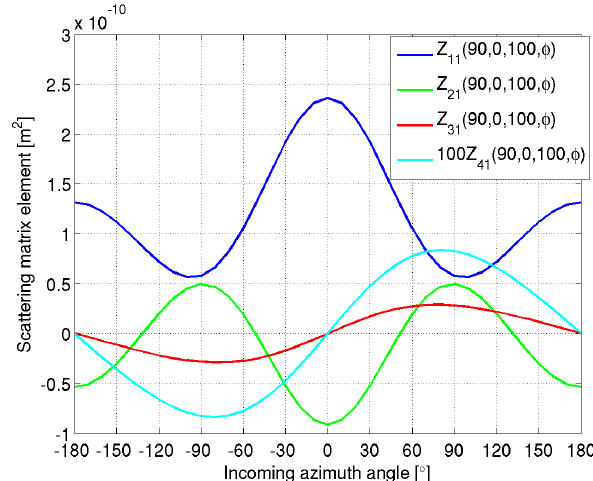
Fig. 7. Scattering matrix elements as a function of incoming azimuth angle, for horizontally aligned oblate spheroids with an aspect ratio of 2, an equivalent diameter size of 170 µm and a frequency of 347.5 GHz . In the nomenclature of Eq. 1, the zenith and azimuth angles of ˆn are 90 ◦ and 0 ◦ , respectively, and the zenith angle of ˆn 0 is 100 ◦ . The Z 41 is increased by a factor of 100, to make the angular variation visible.